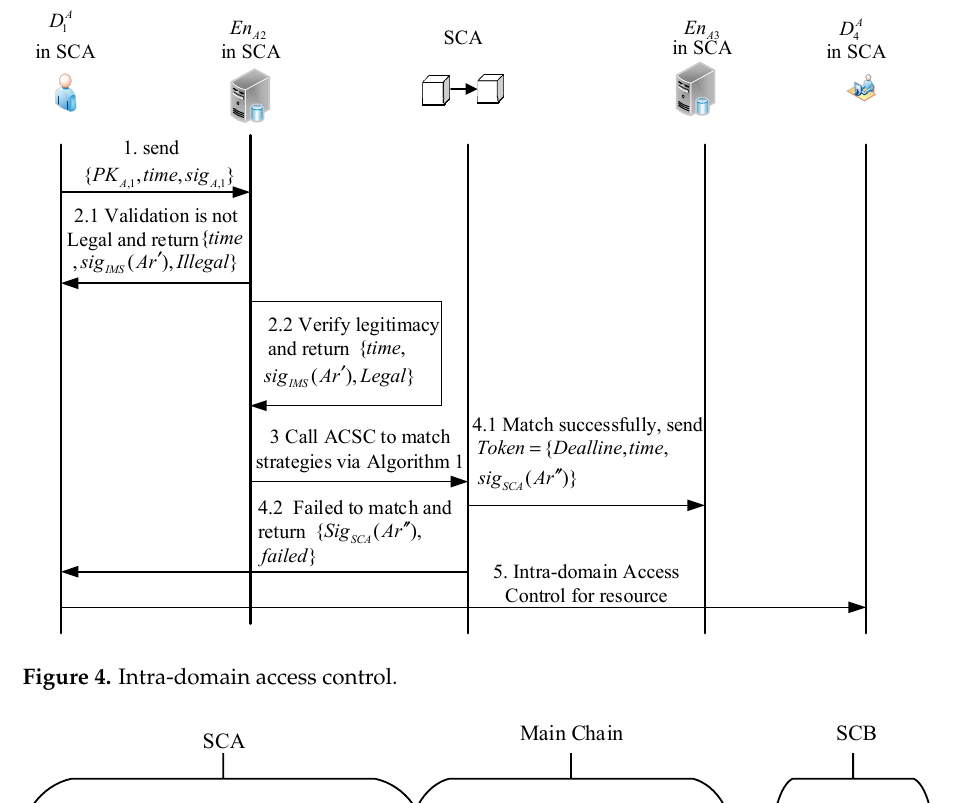
Figure 4. Intra-domain access control.